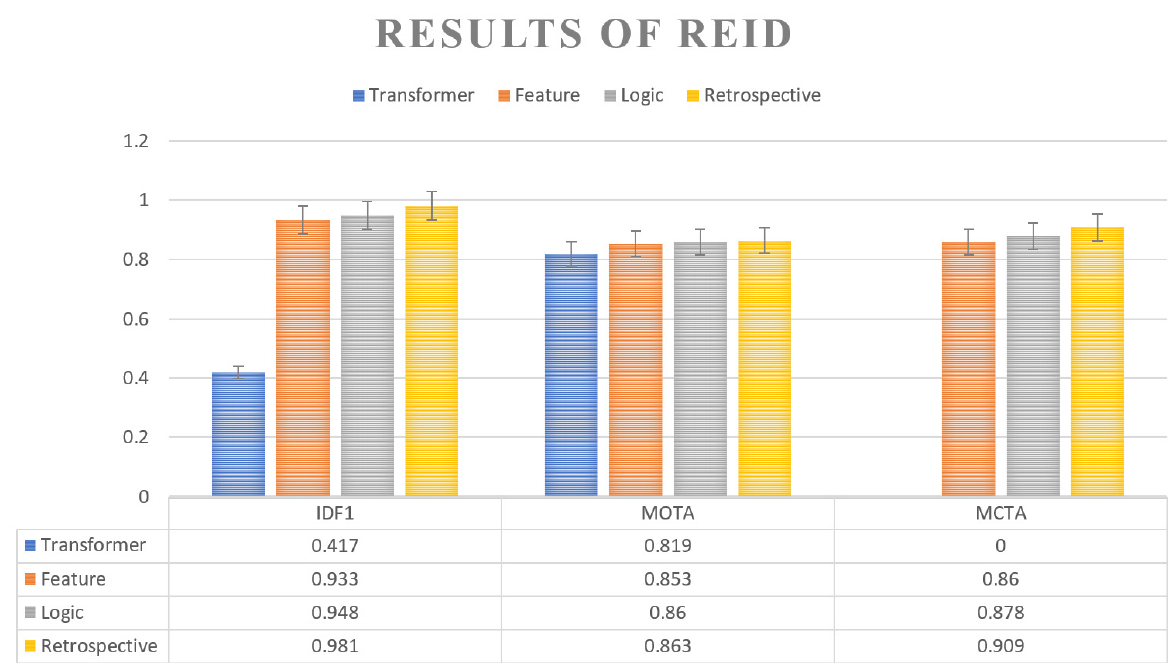
Figure 11. Results of ReID ablation experiments based on